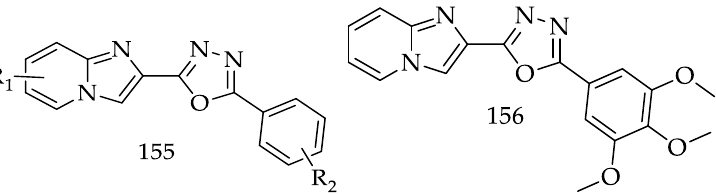
As a result of screening the all-synthesized compounds, derivative ( 156) was found to be the most potent on A549 cells with an IC 50 value of 2.8 ± 0.02 μM , as a comparison to podophyllotoxin (standard drug), with an IC 50 value of 0.09 ± 0.01. The effect of